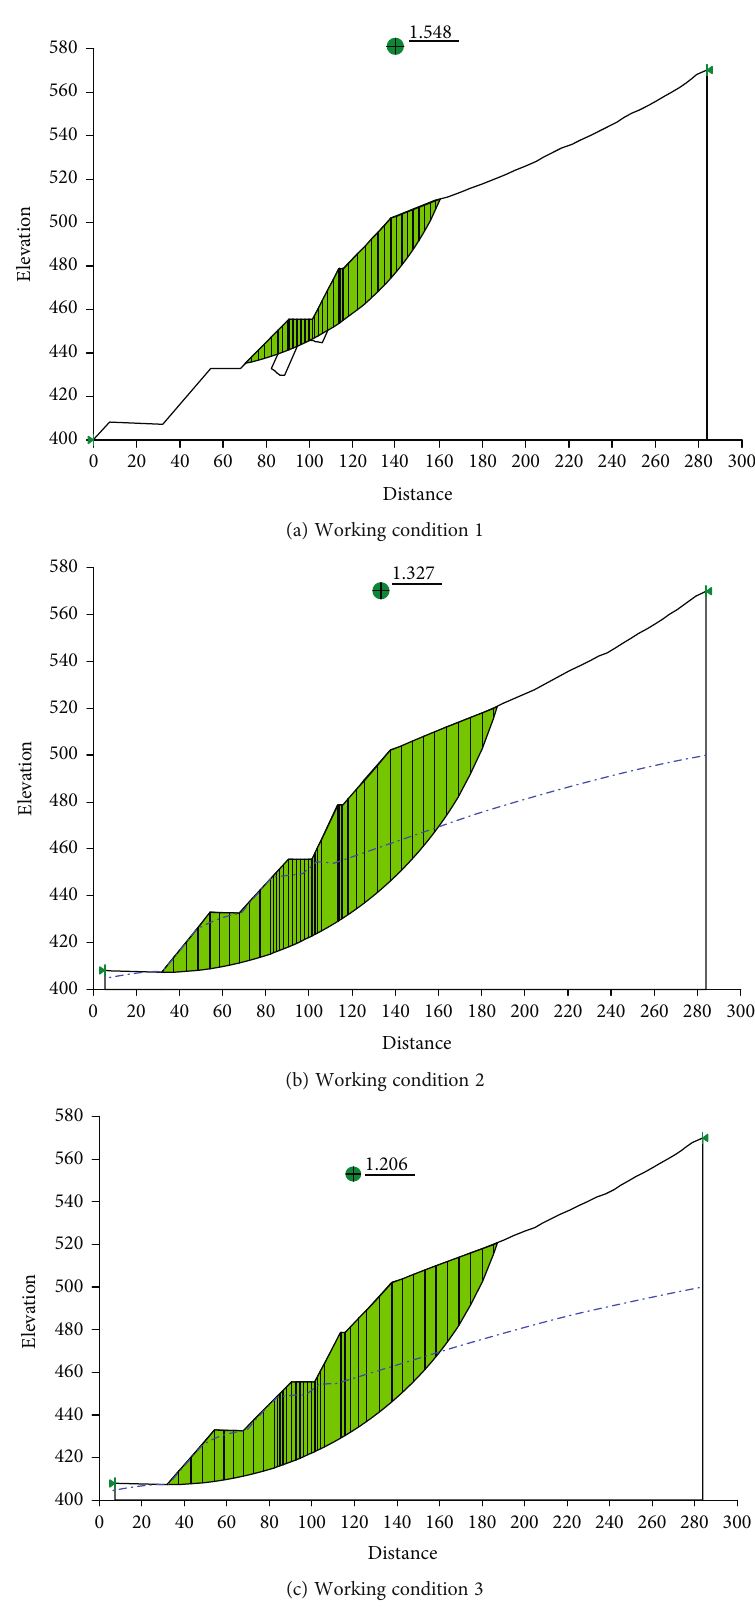
Figure 8: Seepage calculation diagram of section